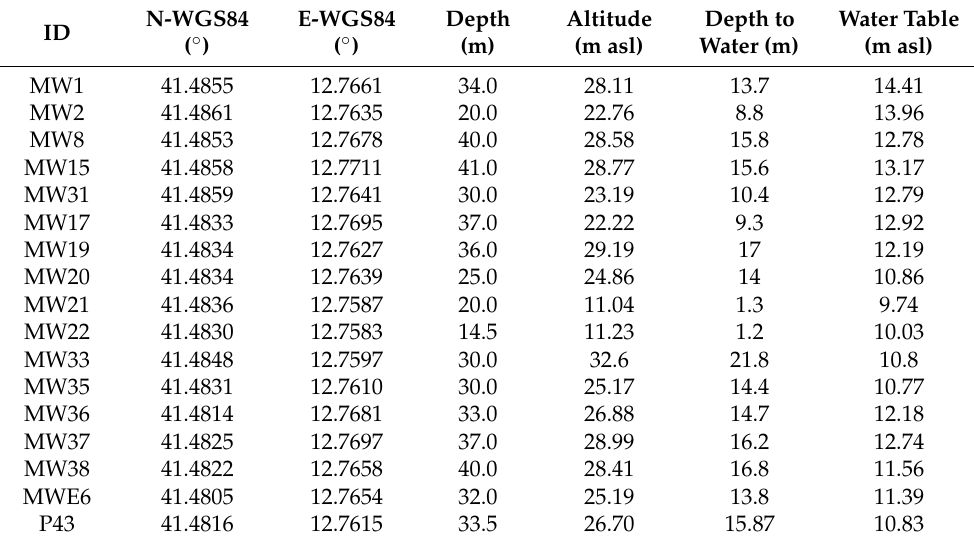
Figure 2. Geological map and cross section of the landfill well monitoring network area. Table 1. Coordinates (WGS84) and depth of the landfill monitoring wells.